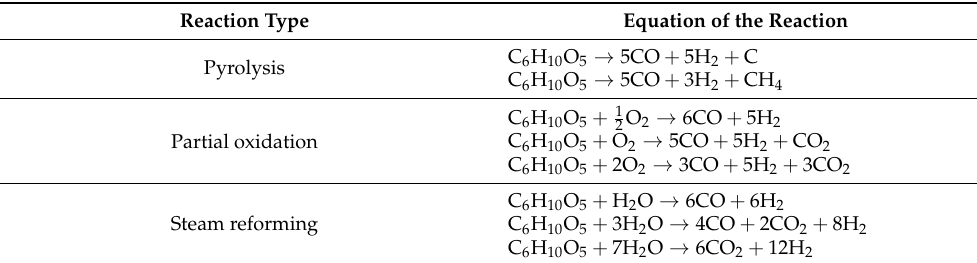
Table 2. Basic reactions for the gasification process for biomass